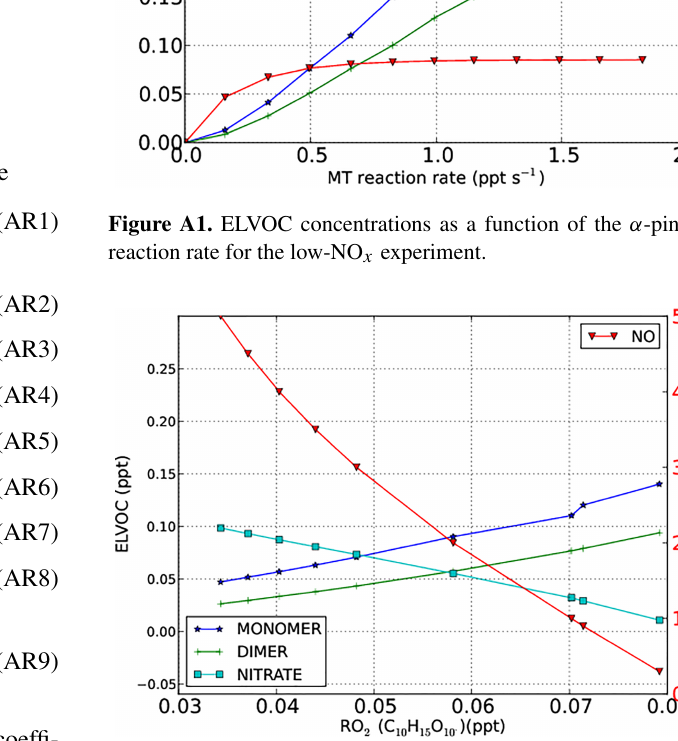
Figure A2. ELVOC concentration as a function of the RO 2 concen- tration in the high-NO x